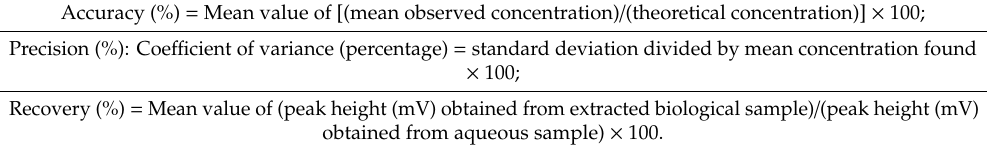
Figure 11. Typical chromatograms of extracted blank plasma ( A ), extracted blank brain homogenate ( B ), plasma extracted catechin hydrate (CH) ( C ), extracted brain homogenate catechin hydrate (CH) ( D ), plasma extracted quercetin (IS) ( E ), and extracted brain homogenate quercetin (IS) ( F ). Table 8. Definitions and formulas used in the